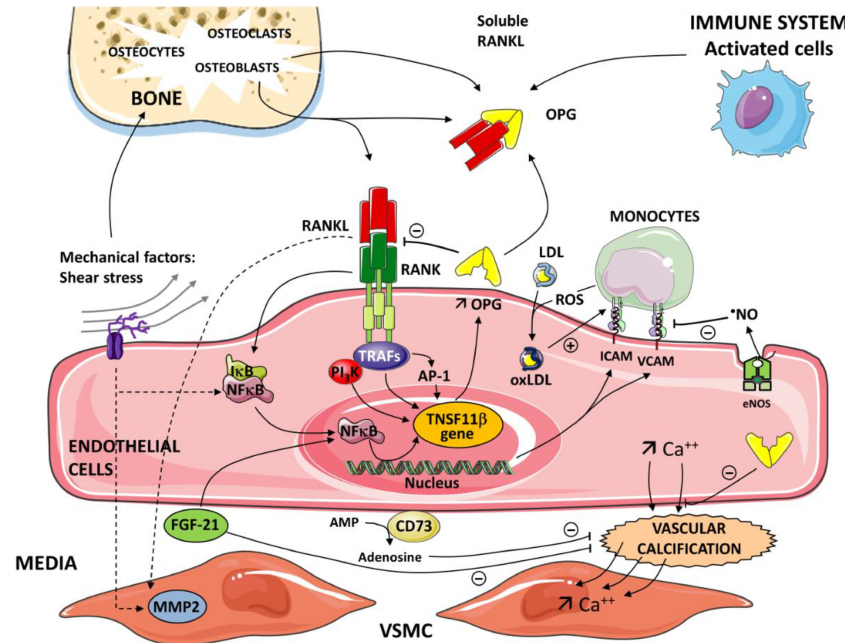
Figure 1. Critical role of the nuclear factor kappa-B/nuclear factor kappa-B ligand/osteoprotegerin (RANK/RANKL/OPG) axis in the pathogenesis of inflammatory processes and vascular